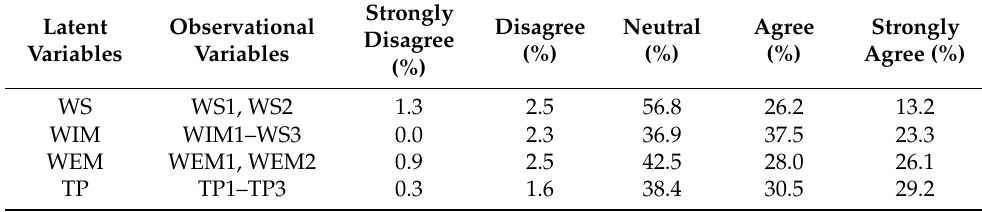
Table A3. Responses to latent variables for the older workers’ group (Group